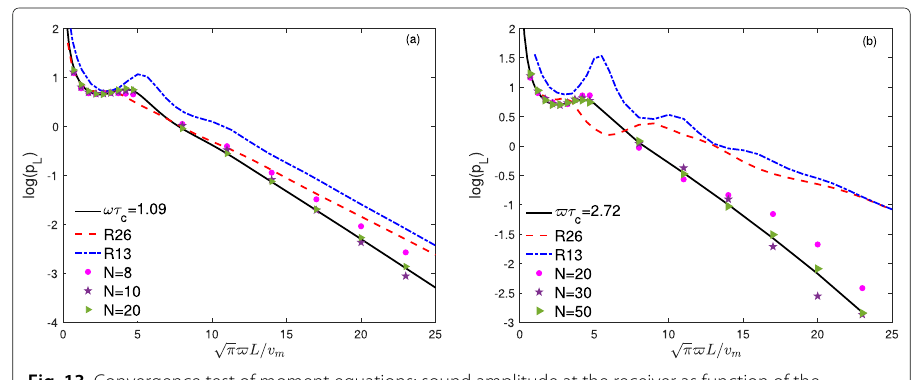
Fig. 13 Convergence test of moment equations: sound amplitude at the receiver as function of the √ π(cid:15) L / v dimensionless length m . Solid lines represent the accurate results from the Shakhov model (44) solved by the discrete velocity method [69]. Symbols are approximate solutions of the Shakhov model when the molecular velocity space v is discretized according to Gauss-Hermite quadrature of order N ; these solutions are equivalent to those of Grad moment equations (having ( N + 1 )( N + 2 )( N + 3 )/ 6 moments) that are accurate up to the order of Kn N −